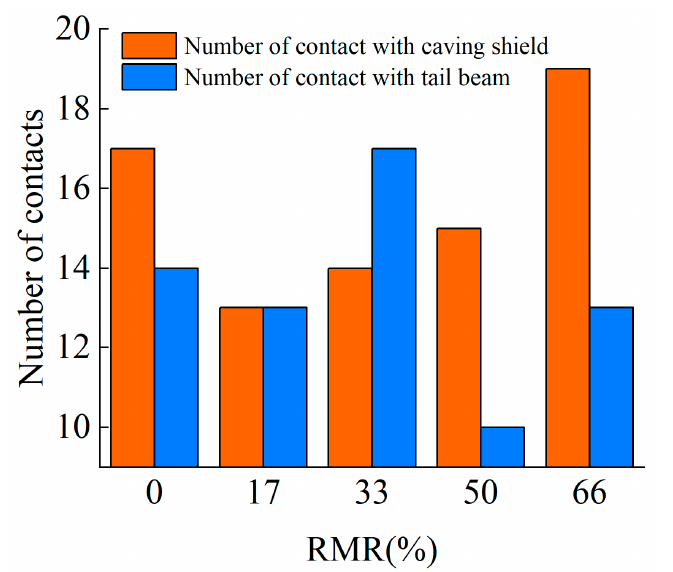
Figure 16. Number of contacts between coal gangue particles with different RMRs and caving shield and tail beam.